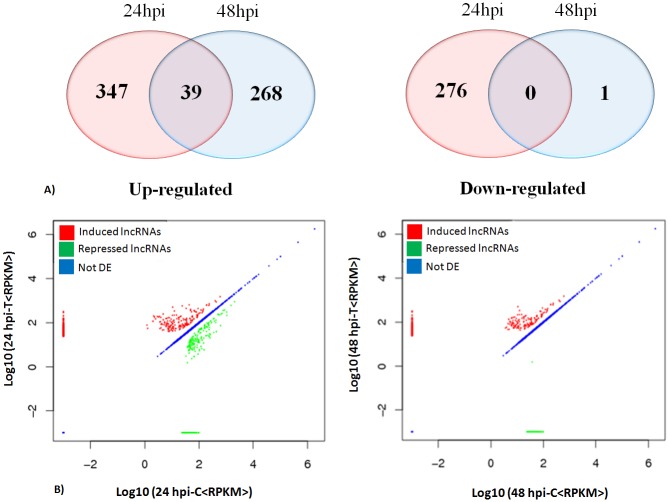
Differential expression of B. napus lncRNAs post inoculation with S. sclerotiorum.Venn diagram representation of differentially expressed lncRNAs at 24 hpi (A) and 48 hpi (B). Scatter plot representing the correlation analysis of differentially expressed lncRNAs at 24 hpi (C) and 48 hpi (D).